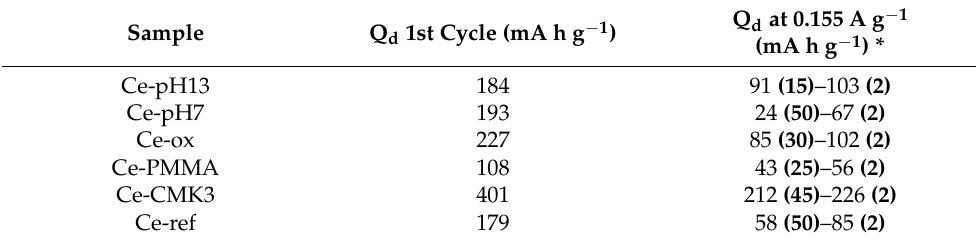
Table 2. First cycle discharge capacity (Qd) and range of capacity values displayed for the ceria